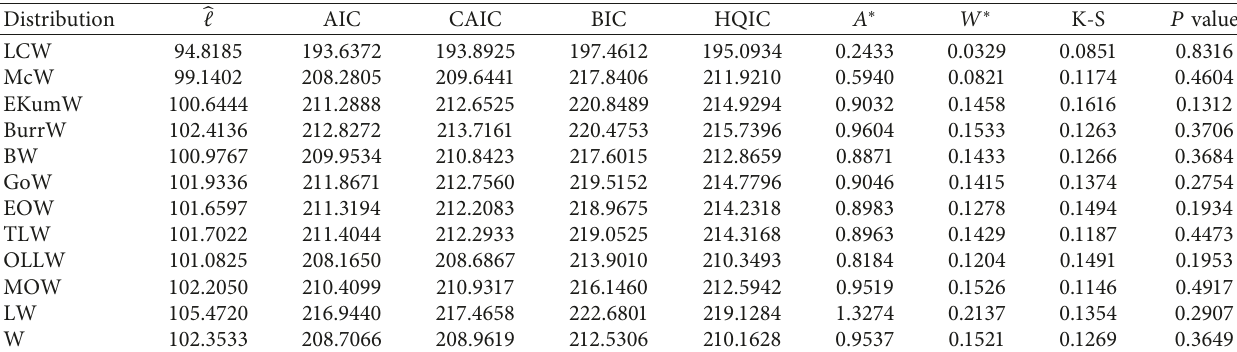
Table 6: 􏽢 ℓ , AIC, CAIC, BIC, HQIC, A ∗ , W ∗ , K-S, and P values for failure time